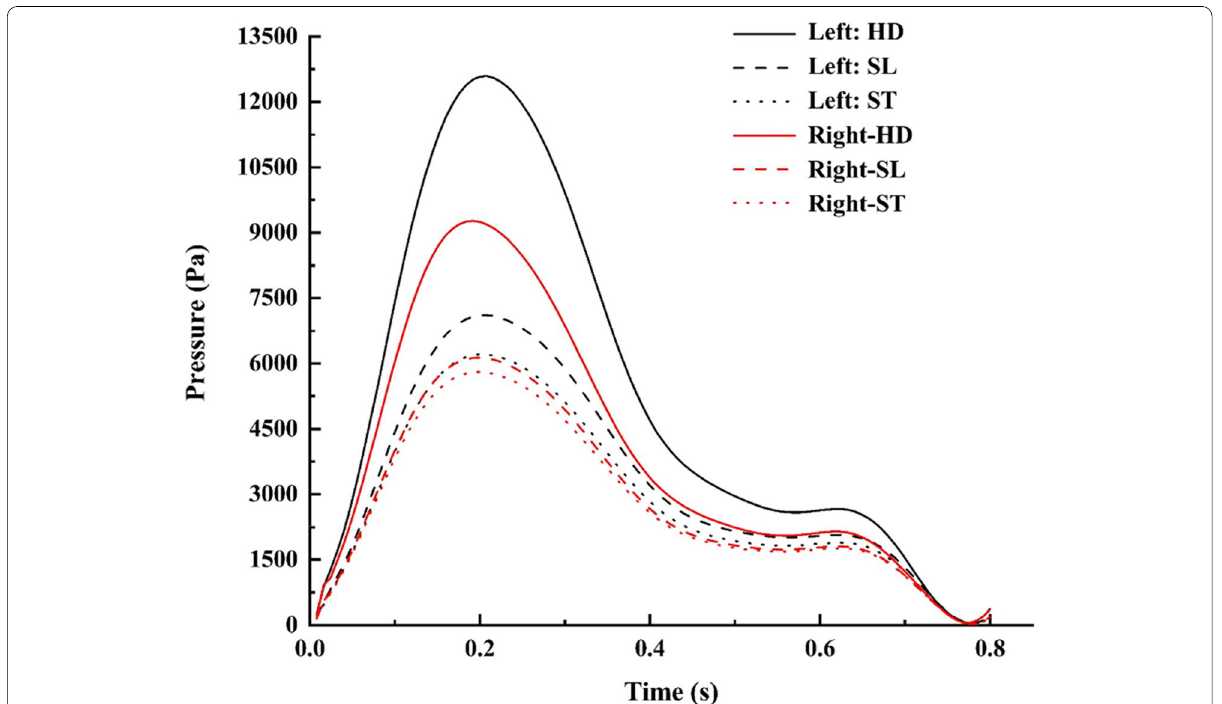
Fig. 11 Pressure comparison during various